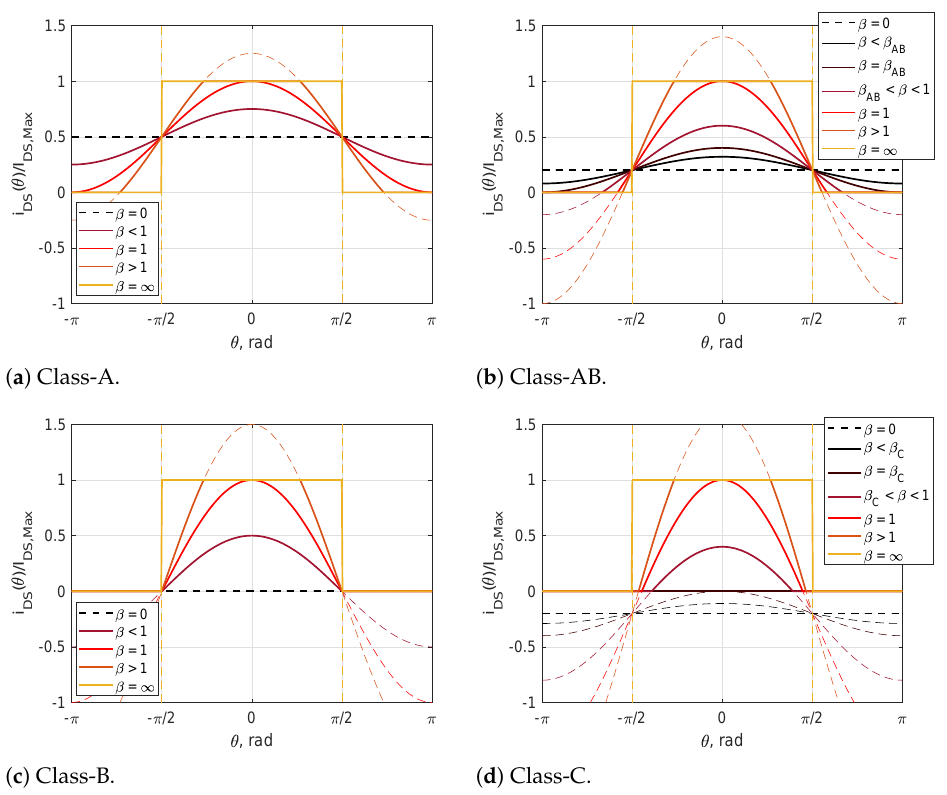
Figure 4. Normalized drain-source current at different β . Dashed lines show the mathematical sinusoids that define the waveforms from which the peak current I p can be